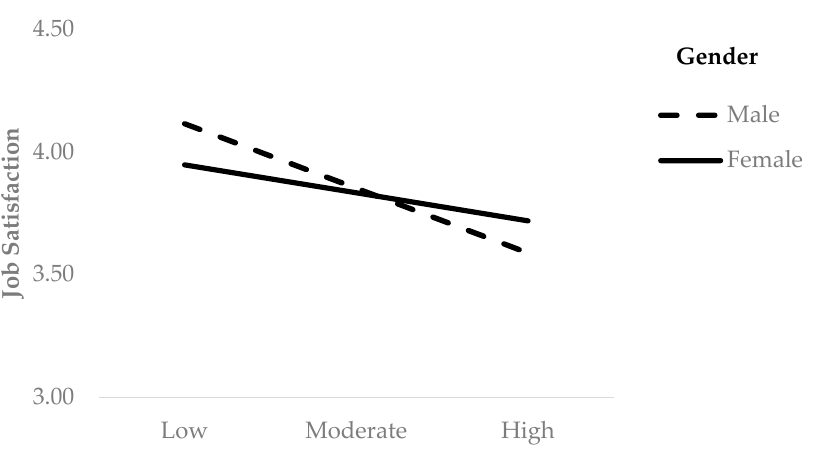
Figure 7. Maladaptive downregulation of negative emotions predicting job satisfaction as a function